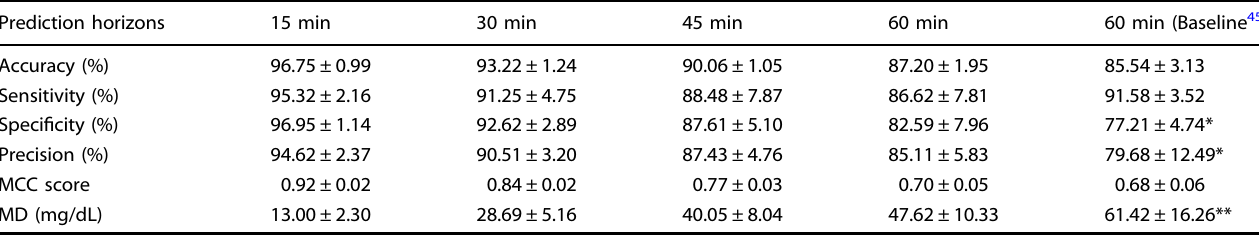
Table 4. Results of hyperglycemia prediction (Mean ± SD) evaluated on 12 clinical T1D subjects. Prediction horizons